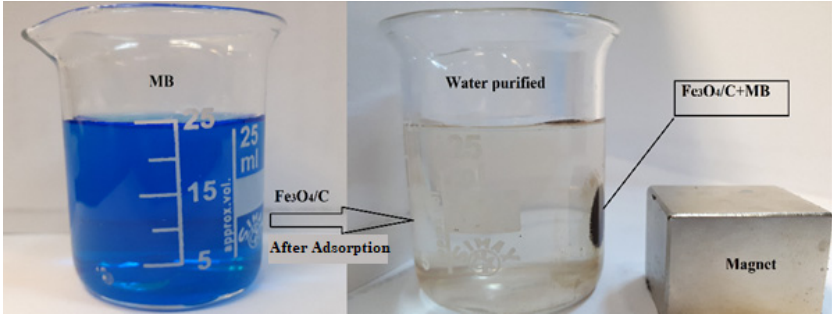
Fig. 14: Photograph of MB adsorption with Fe